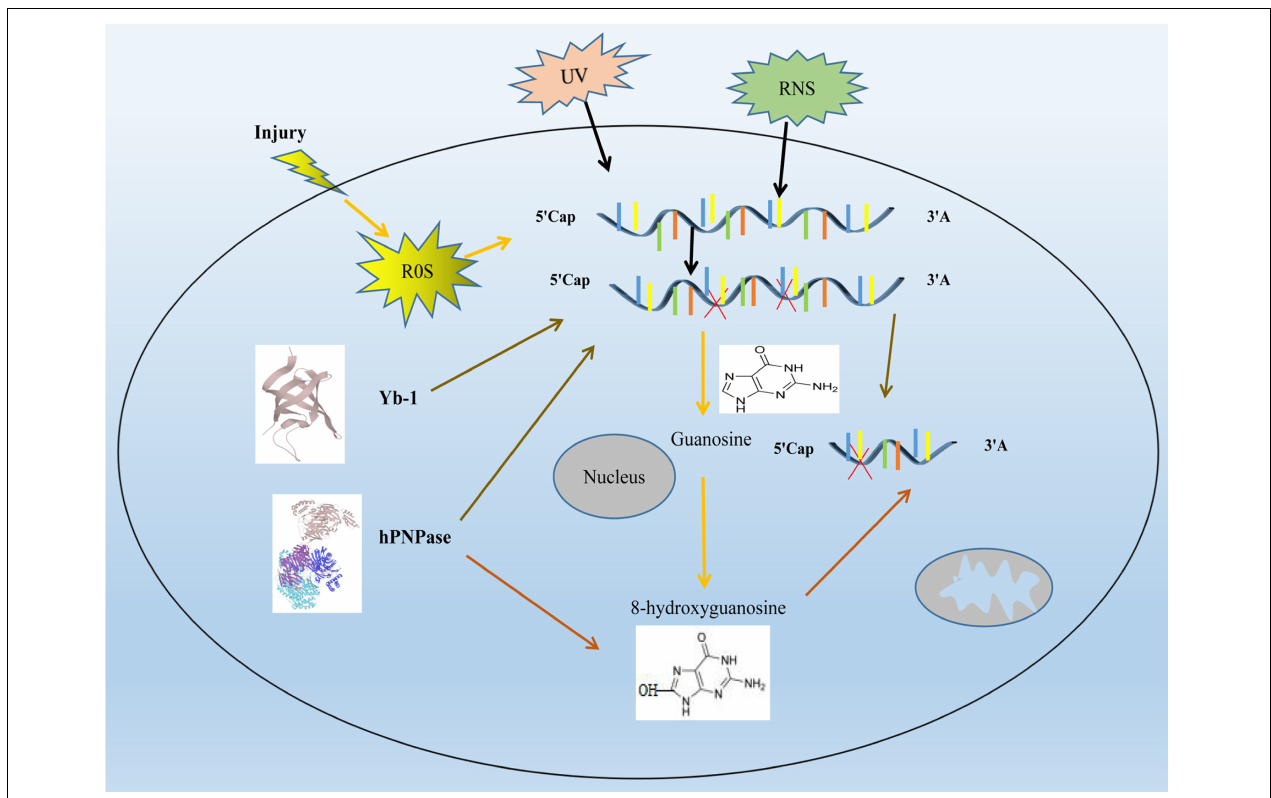
FIGURE 1 | Research progress on oxidative damage mechanism of RNA. Ultraviolet (UV), reactive oxygen species (ROS) and reactive nitrogen species (RNS), will cause damage to RNAs RNA oxidative damage in cell. The increase of intracellular ROS leads to oxidative damage to RNA, which leads to an increase in intracellular 8-hydroxyguanosine (8-OHG), it is formed because the guanosine in RNA in RNA can be oxidized by highly reactive hydroxyl radicals to form a C8-OH adduct radical. hPNPase can degrades damaged RNA and reduces the content of 8-OHG, thereby reducing RNA damage. Yb-1 attenuates RNA damage by silencing damaged RNA. RNA molecules are shown as blue lines. red X represent the damaged